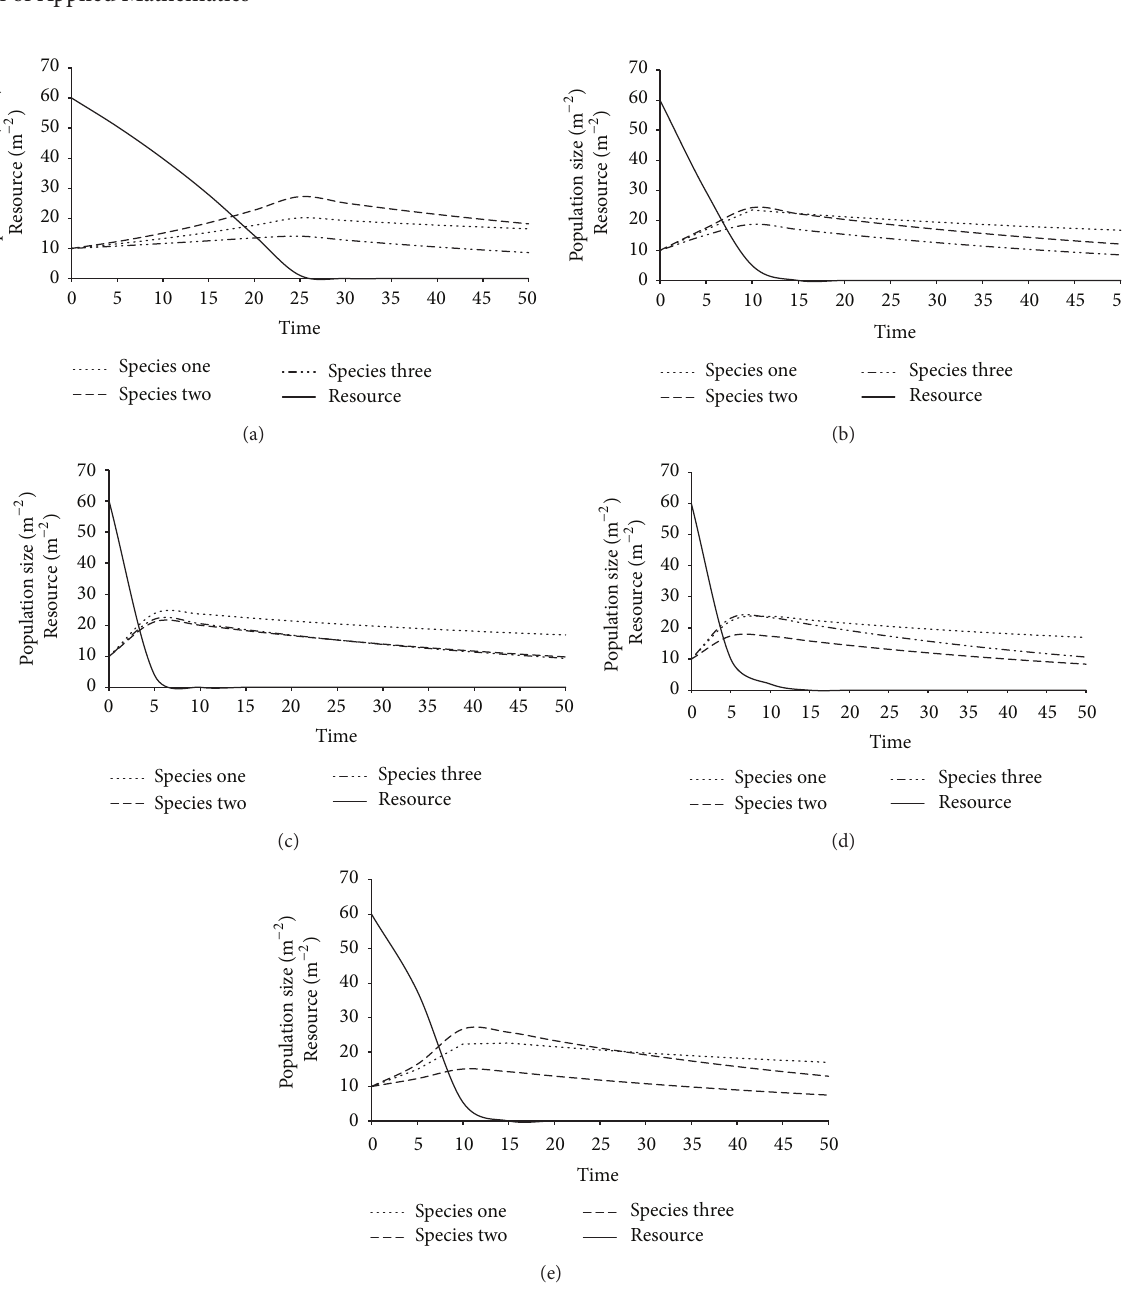
Figure 6: Behavior of the isoclines for three species competing for a single resource when both species initial population size are the same; curves (a)–(e) show the behavior of population size for each resource at temperatures 10 ∘ C, 15 ∘ C, 20 ∘ C, 25 ∘ C, and 30 ∘ C, respectively. The solid lines represent the resource; species one are represented with round dot lines, species two are represented with dash lines, and species three are represented with long dash dot lines and all species have different growth